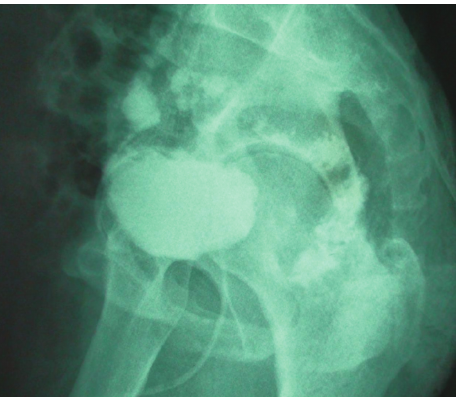
Figure 1: Preoperative oblique cystography shows extravasation of contrast material through the fistula from bladder to the rectum.